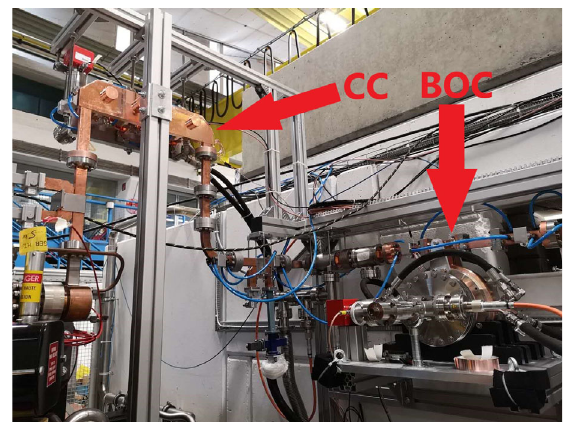
FIG. 7. Installation of the pulse compression system.